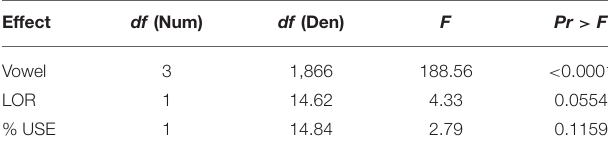
TABLE 2 | Type III tests of fixed effects